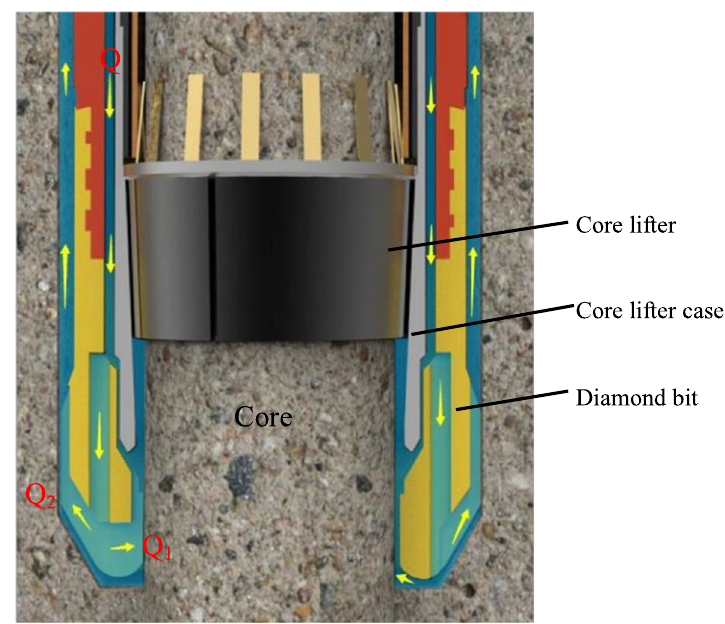
Fig. 4 Drilling tool sub-assembly water passage